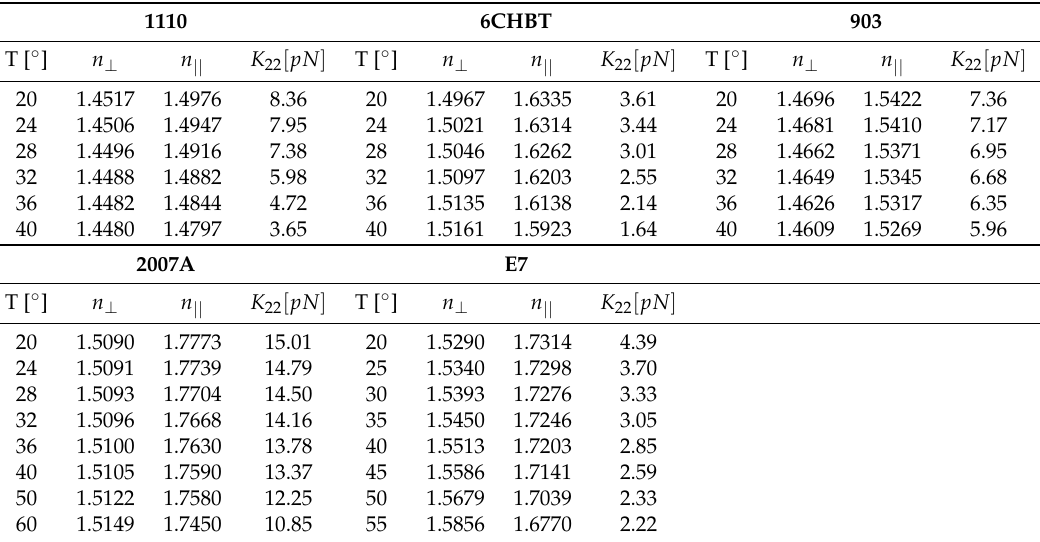
Table 1. Measured values of refractive indices and Frank elastic constant K 22 for different